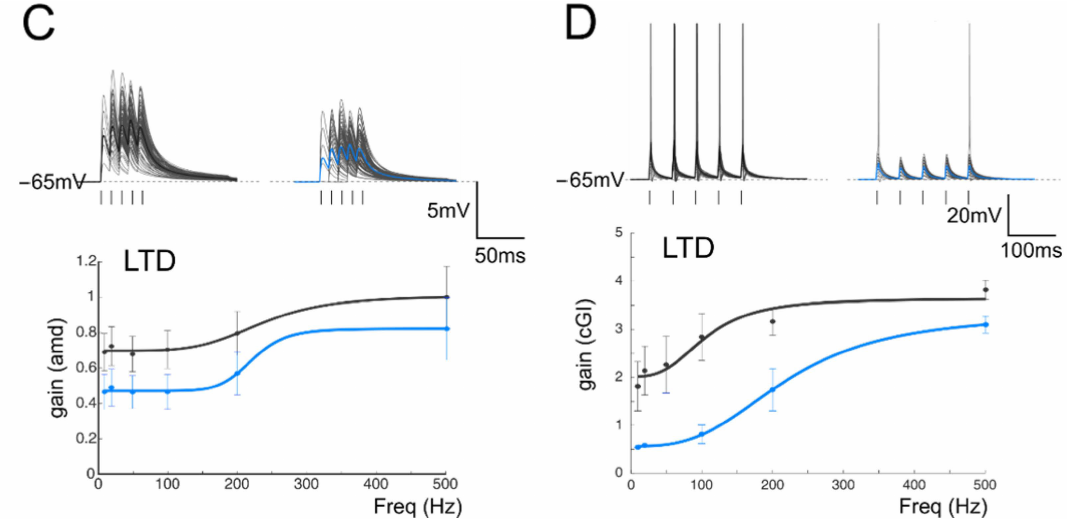
Figure 6. Simulation of gain modulation by synaptic plasticity. ( A ) Top Voltage traces obtained from a modeled GrC showing subthreshold responses to repetitive stimulation at 100 Hz in the control (left) and following LTP (right). Average traces (thick, gray and red) show an increase in the average responses. Bottom. Gain curves of the cell shown in the top traces before (black) and after LTP (red). The network configuration (see Supplemental Materials) was one mf and three GoCs ( B ) Top. In a different network configuration (three mfs and two GoCs), repetitive stimulation at 20 Hz (10 traces) generated a prevalence of firing responses to repetitive stimulation in the control (left) and following LTP (right). Average traces (thick, gray and red) show an increase in the number of spikes and decreases in the spike delay and variability. Bottom. Gain curves of the cell shown in the top traces before (black) and after LTP (red). ( C ) Top Voltage traces obtained from a modeled GrC showing subthreshold responses to repetitive stimulation at 100 Hz in the control (left) and following LTD (right). Average traces (thick, gray and blue) show a decrease in the average responses following LTD. Bottom. Gain curves of the cell shown in the top traces before (black) and after LTD (blue). The network configuration (see Supplemental Materials) was one mf and three GoCs. ( D ) Top. In a different network configuration (three mfs and two GoCs), repetitive stimulation at 20 Hz (10 traces) generated a prevalence of firing responses in the control (left) and following LTD (right). Average traces (thick, gray and blue) show a decrease in the number of spikes and increases in the spike delay and variability. Bottom. Gain curves of the cell shown in the top traces before (black) and after LTD